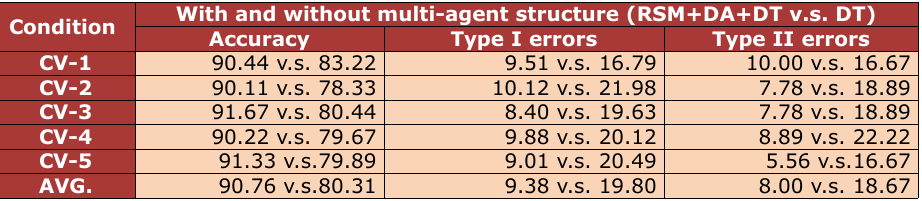
Table 4. The results of scenario 1